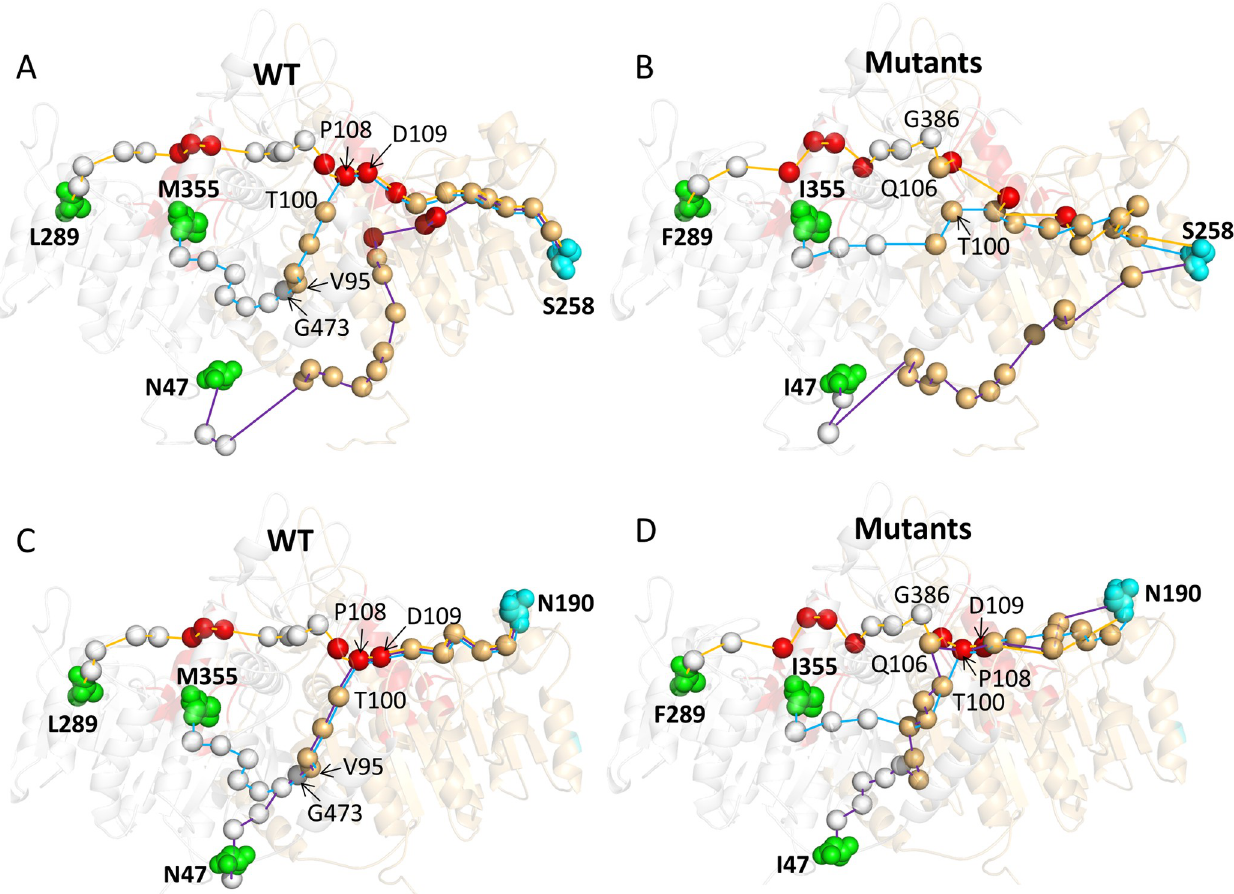
Fig 8. Allosteric paths originating at three mutational sites and terminating at S258 in the WT (A) and mutant states (B), as well as terminating at N190 in the WT (C) and mutant states (D), respectively. The TNSALP structure is depicted as represented by a semitransparent colored cartoon, and the starting and ending residues of all the paths are represented as green and cyan spheres, respectively. The alpha-carbon of the path through the residues is shown as silver (chain A ) and orange (chain B ) spheres, in which active sites are represented by red